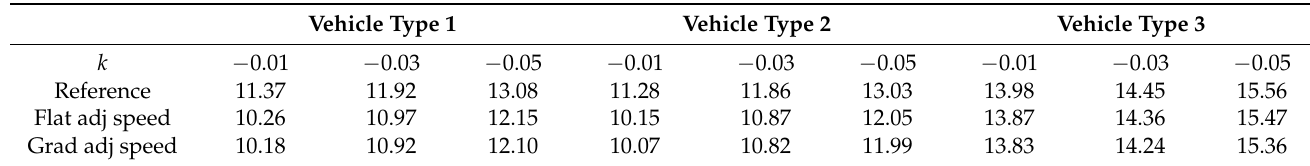
Table 10. Percentage of regenerative energy under alternative speed profiles, gradient assumptions, and vehicle types (symmetric valley, WMTC Reference Cycle